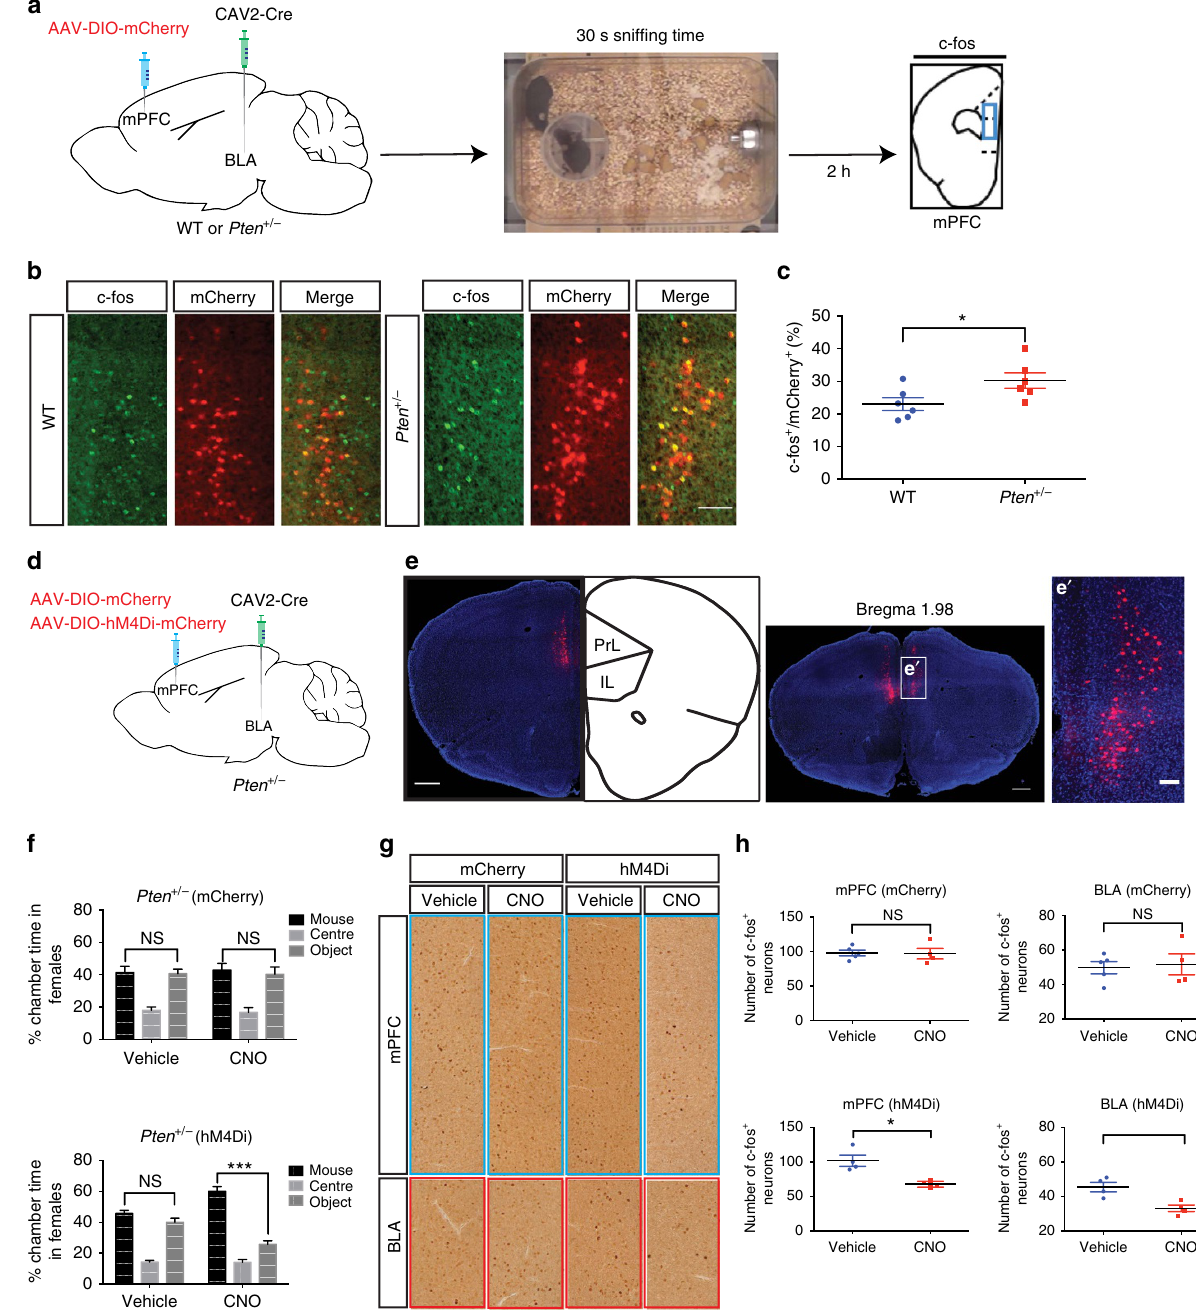
Figure 6 | Reducing activity in the mPFC to BLA projections corrects social behavioural deficits in Pten mutant mice. ( a ) Diagrams showing experimental design. To label BLA-projecting mPFC neurons, CAV2-Cre was injected into the BLA, and AAV-DIO-mCherry was injected into the mPFC. Social exposure was controlled for 30s sniffing time. ( b ) Representative images of mCherry (red) and c-fos (green) double labelling in the mPFC of WTand Pten þ / (cid:2) mice. Scale bar, 100 m m. ( c ) Quantification of the percentage of c-fos þ neurons within the mCherry þ neuronal population. Independent-sample t tests were used. * P o 0.05. N ¼ 6 animals per genotype. ( d ) Diagrams showing the injection of CAV2-Cre into the BLA and AAV-DIO-mCherry or